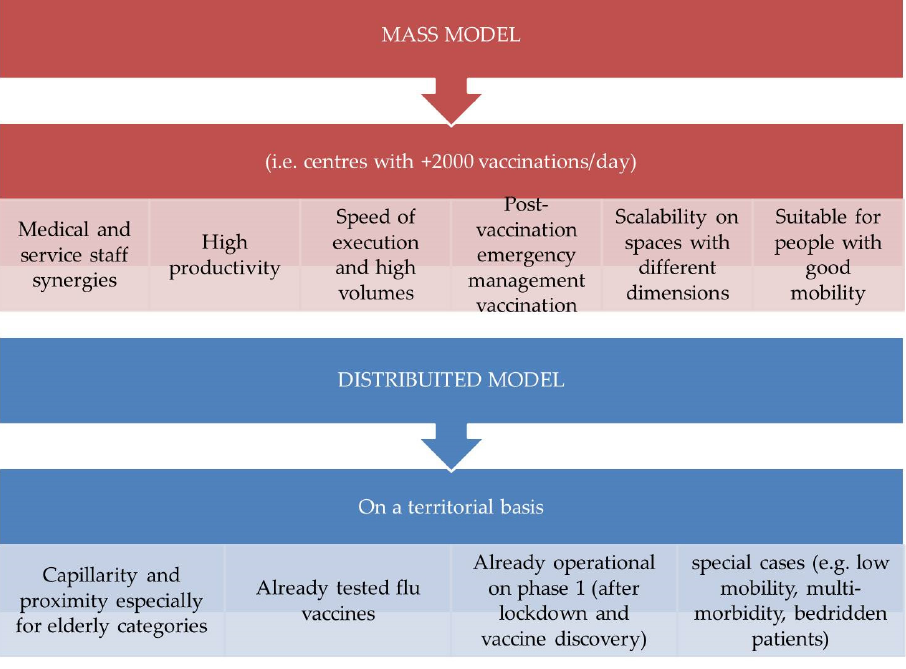
Figure 1. The main models related to vaccines centres spreads in the world.